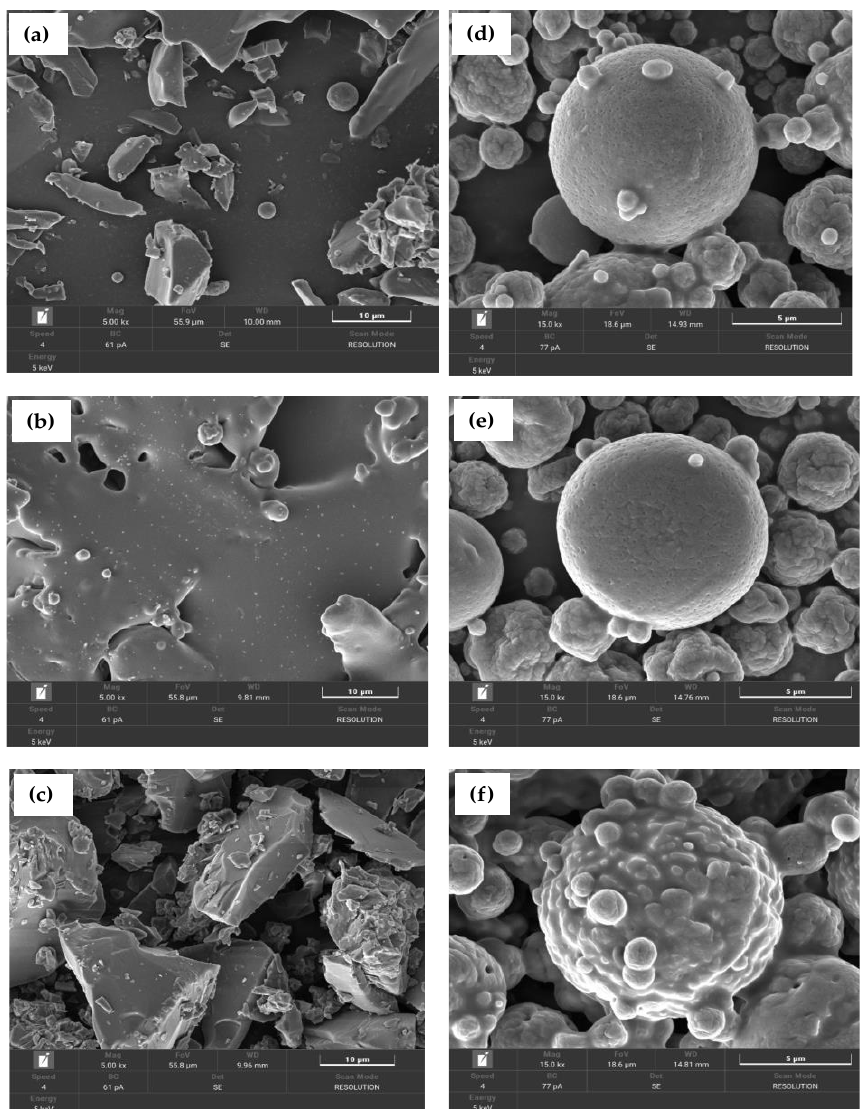
Figure 2. FE-SEM images of microencapsulated bioactive compound nanoparticles (components of 2% chitosan combined with 2% Tween 80; ( a , d ): unencapsulated and encapsulated C. sativa , ( b , e ): unencapsulated and encapsulated C. indica ; ( c , f ): unencapsulated and encapsulated M. speiosa .